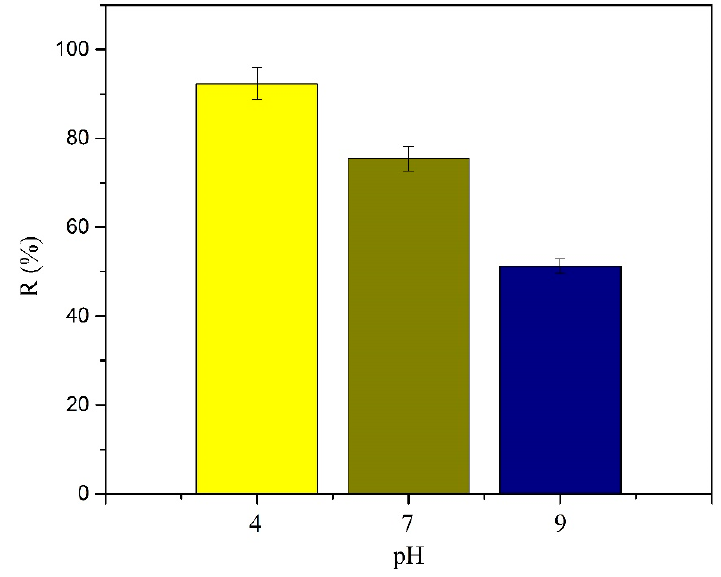
Figure 9. Effect of pH on the percentage of SMX adsorption (R (%)) onto MY@MIPs. Figure 9. E ff ect of pH on the percentage of SMX adsorption (R (%)) onto MY@MIPs.